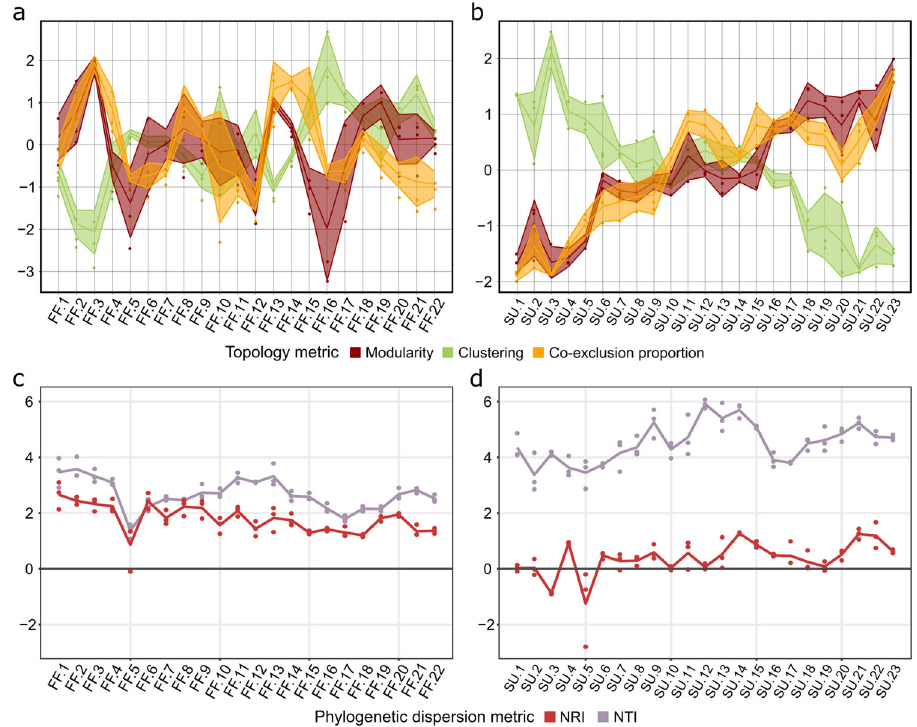
Fig. 2 Evolution of bacterial community structure and ecological processes shaping community assembly and succession. Left panels correspond to FF-WWTP and right panels to SU-WWTP. a, b Temporal patterns of modularity and clustering coef fi cients, and nodes co- exclusion proportion are represented in red, green, and orange, respectively. The central line corresponds to average values ( n = 3) of each sample, and the shaded areas correspond to the standard deviation. c, d Community assembly assessed via net relatedness index (NRI, dark red) and nearest taxon index (NTI, purple). Dots represent sample data ( n = 3) and lines represent the average value per